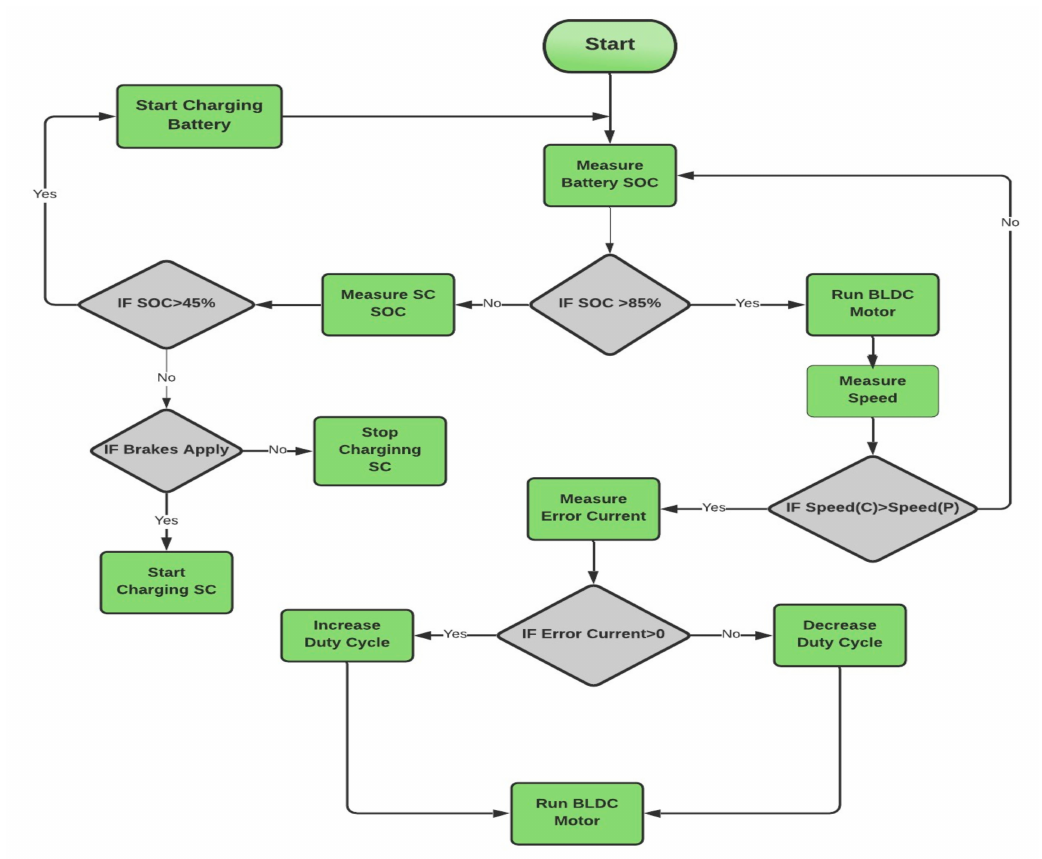
Figure 5. Flowchart for proposed